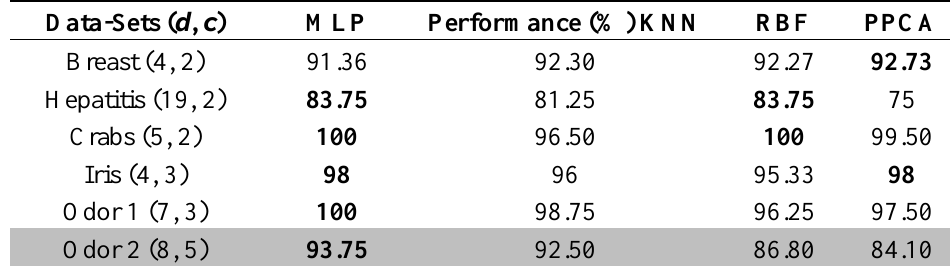
Table 3. Classification performance of different classifiers based on the six data-sets. 10-fold cross validation approach is used to evaluate the classification accuracy (in %). d and c stands for the number of variables and classes